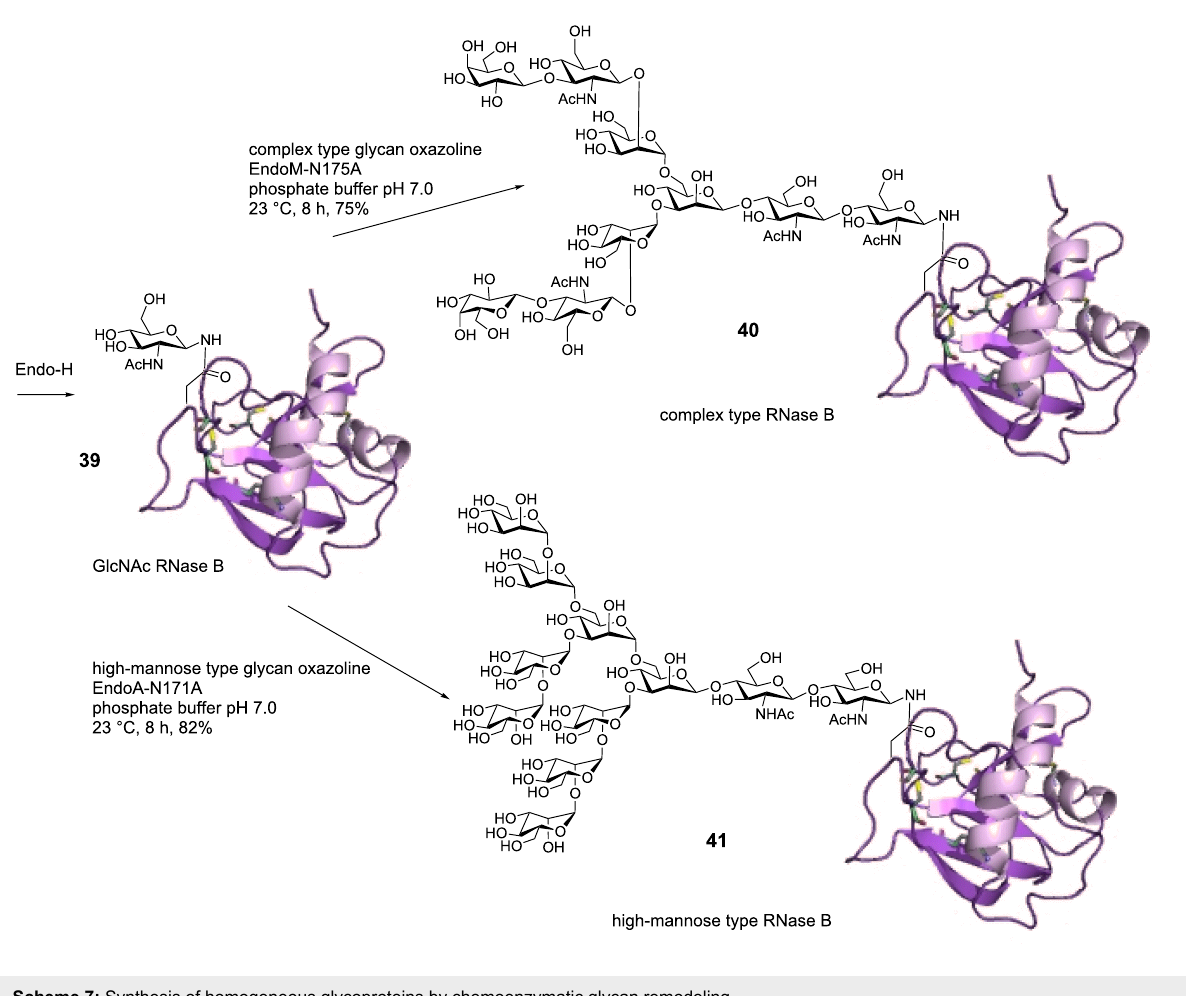
Scheme 7: Synthesis of homogeneous glycoproteins by chemoenzymatic glycan remodeling.